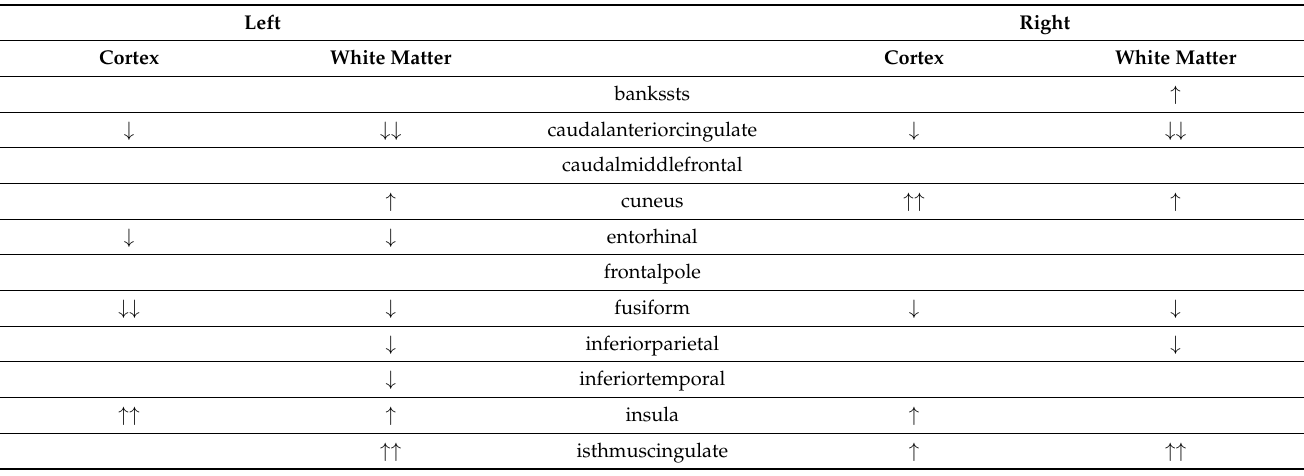
Table 6. The regions whose neuroelectric activity values contributed to the cohort-specific classifiers reported in Table 5 are shown. Activity in regions marked ↑ was higher in the Team-TBI cohort; those marked ↓ were lower. Regions marked ↑↑ or ↓↓ made the largest statistical contribution to the classifier. The results for the 2nd step are highlighted in light gray and for the 3rd step are highlighted in darker gray as in Table 5. These were obtained when the regions which were selected for the 1st (light gray) and 1st and 2nd (dark gray) classification analyses were excluded.